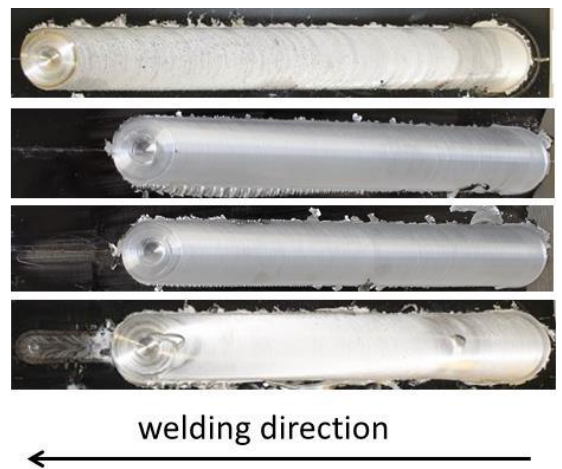
Figure 5. Outlook of weld surfaces.